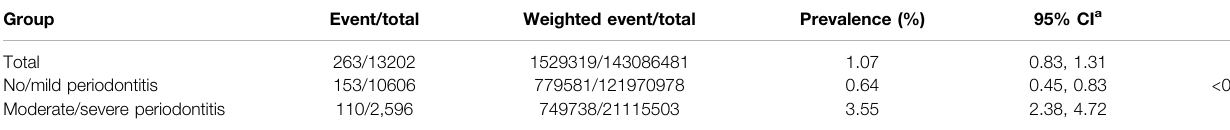
TABLE 2 | Weighted prevalence of heart failure.